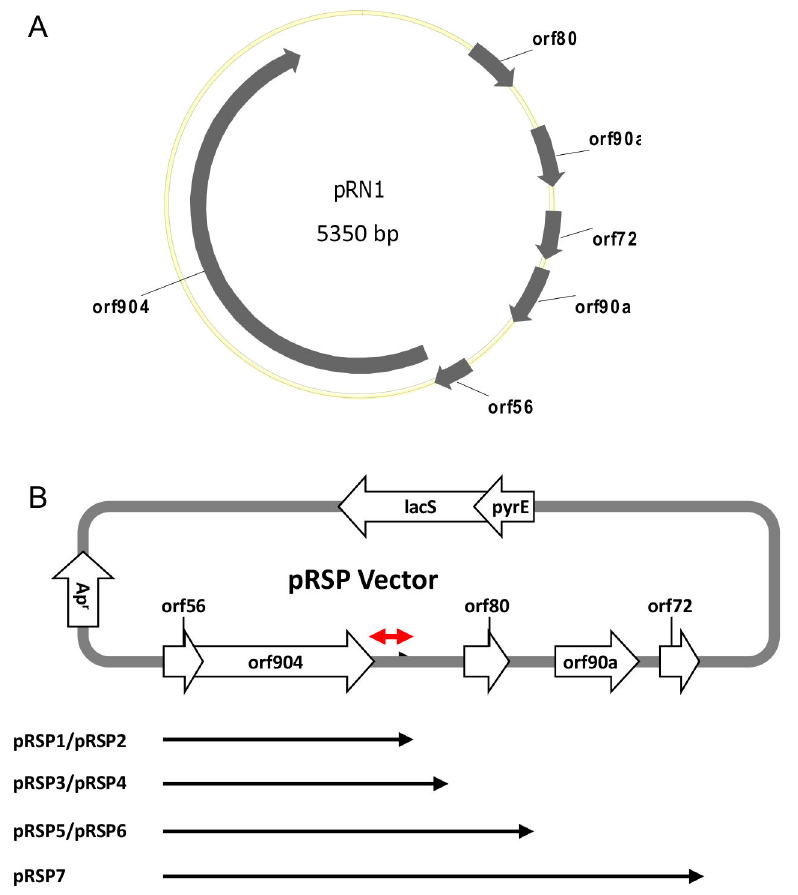
Figure 1. Construction of pRN1-based shuttle vectors. (A) Map of pRN1 showing native genes. (B) Map of pRN1-based shuttle vector(s) showing the 232-bp putative pRN1 origin of replication (red double arrow). Each vector harbors the pUC19 Ap r gene and origin (red box), pyrE with or without lacS and a segment of pRN1 highlighted by black arrows. The lacS gene was deleted from pRSP1, 3, and 5 to generate pRSP2, 4, and